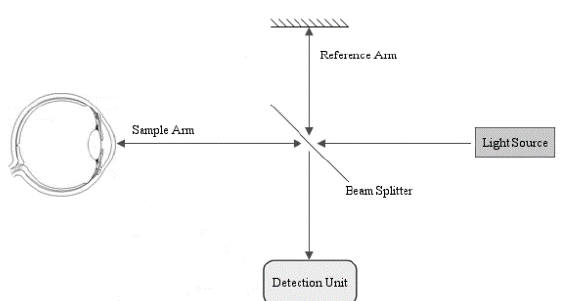
Figure 1. Schematic view of a Fourier-domain (FD) optical coherence tomography (OCT). Components include: reference mirror, sample (in our case, ocular structures), beam splitter, detection unit (a spectrometer or a point detector), and light source (a superluminescent diode or a swept-source laser) [13]. Reference mirror (the line at the top) with associated “reference arm”.